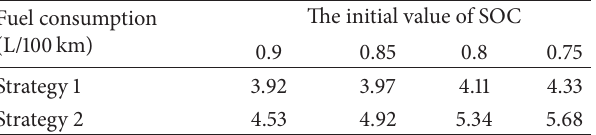
Table 2: Simulation results with different SOC initial values.